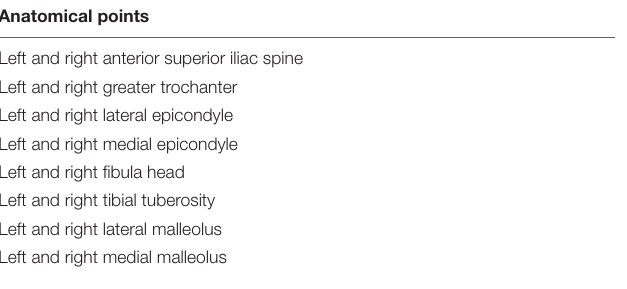
TABLE 1 | List of anatomical points and associated anatomical frames.